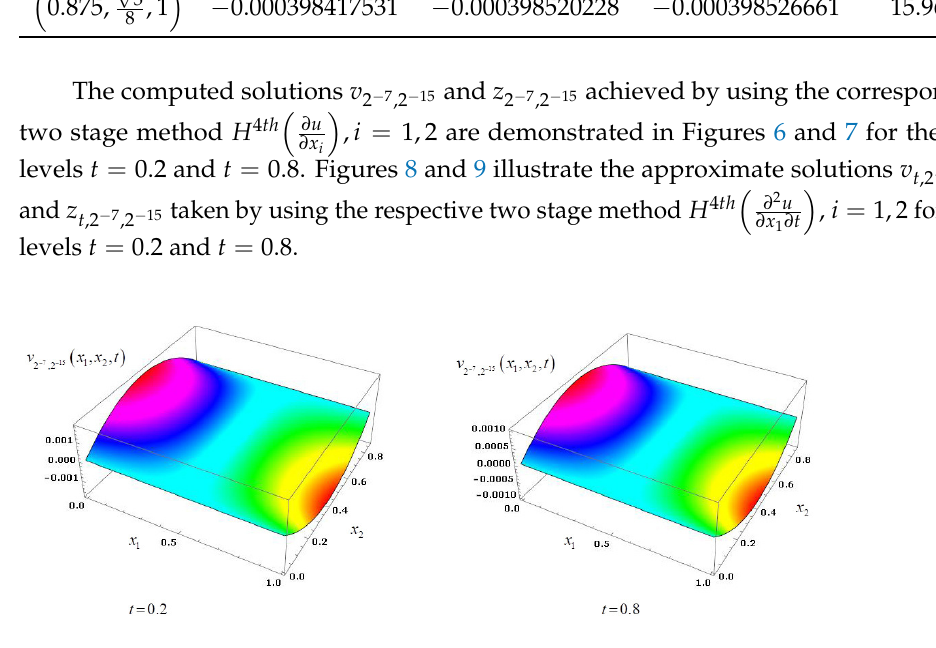
Figure 6. The approximate solution v 2 − 7 ,2 − 15 at time levels t = 0.2 and t = 0.8 obtained by the method (cid:16) (cid:17) ∂ u H 4 th for the Example ∂ x 1